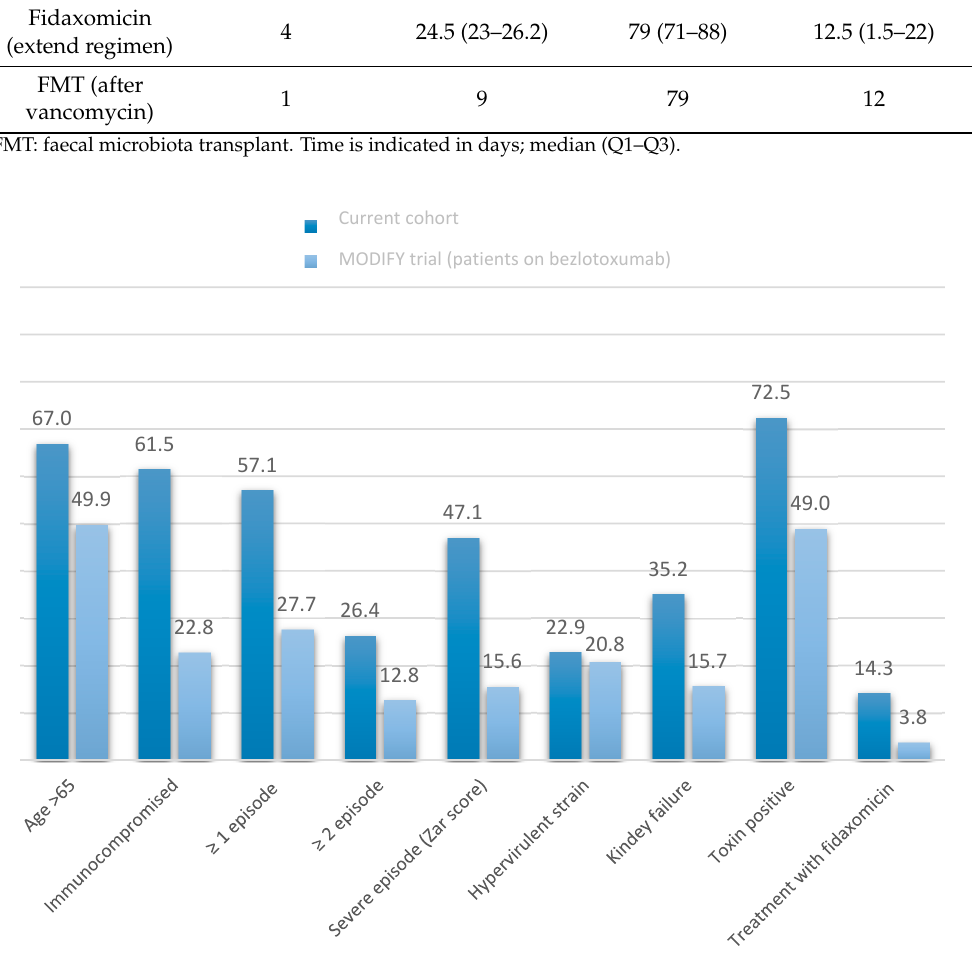
Table 2. Risk factors for recurrent Clostridioides difficile infection (CDI).